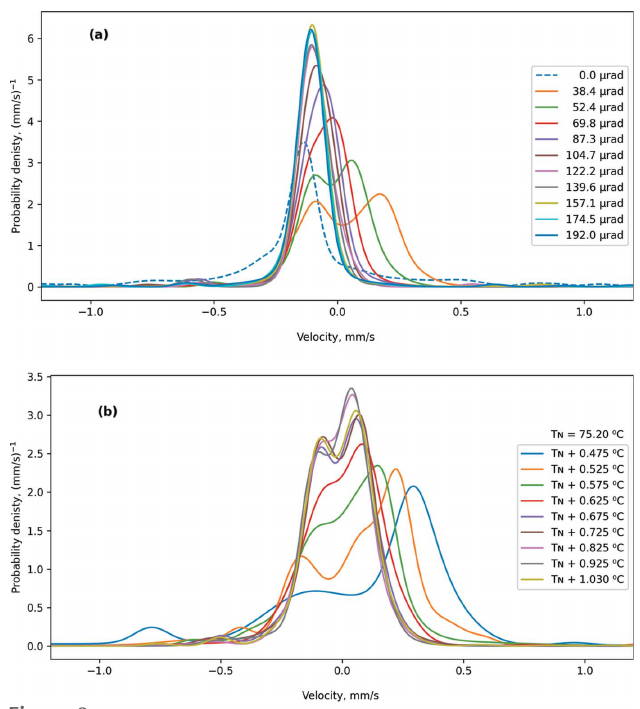
Figure 8 Instrumental functions for various angular positions at temperature T = 76.230 (cid:4) C ( a ) and for various temperatures at the incidence angle (cid:4) = 52 m rad ( b